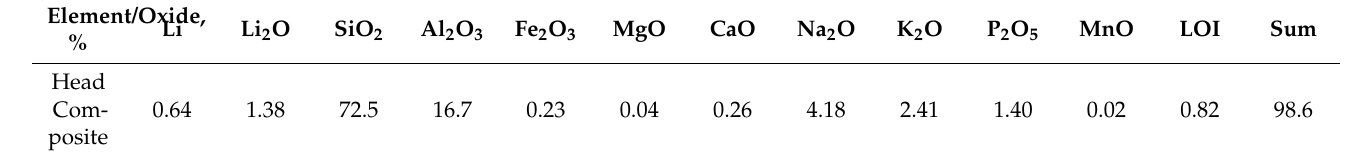
Table 3. Head analysis of HLS composite.